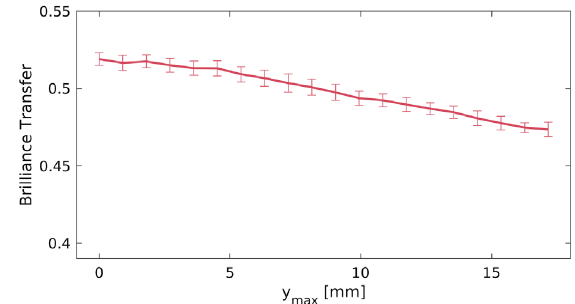
FIG. 11. Brilliance transfer as a function of the ground move- ments. Simulated with a random misalignment of σ ¼ 50 μ m. Brilliance transfer is average in the range 2.3 – 4.0